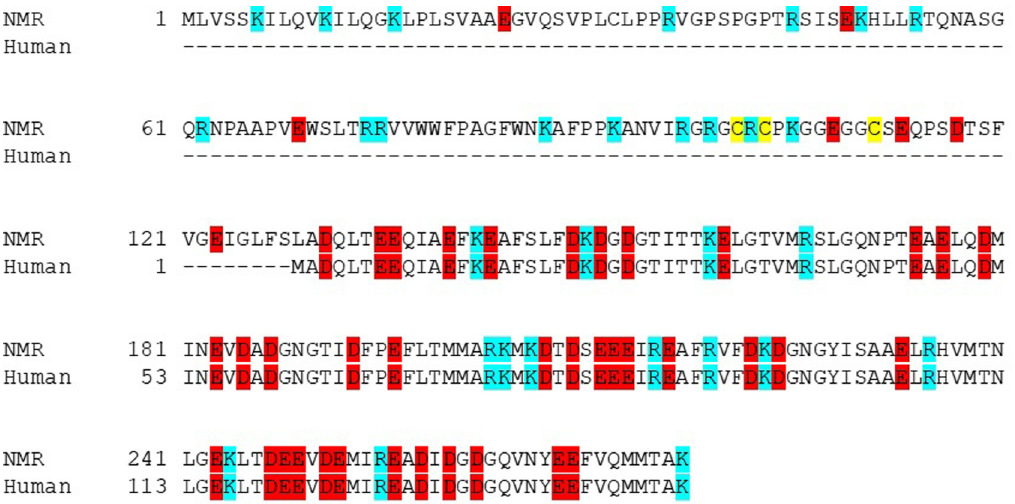
Fig 1. Sequence alignment of naked mole rat and human calmodulins. NMR, naked mole rat. Acidic residues are highlighted in red, basic in blue. Cysteines are highlighted in